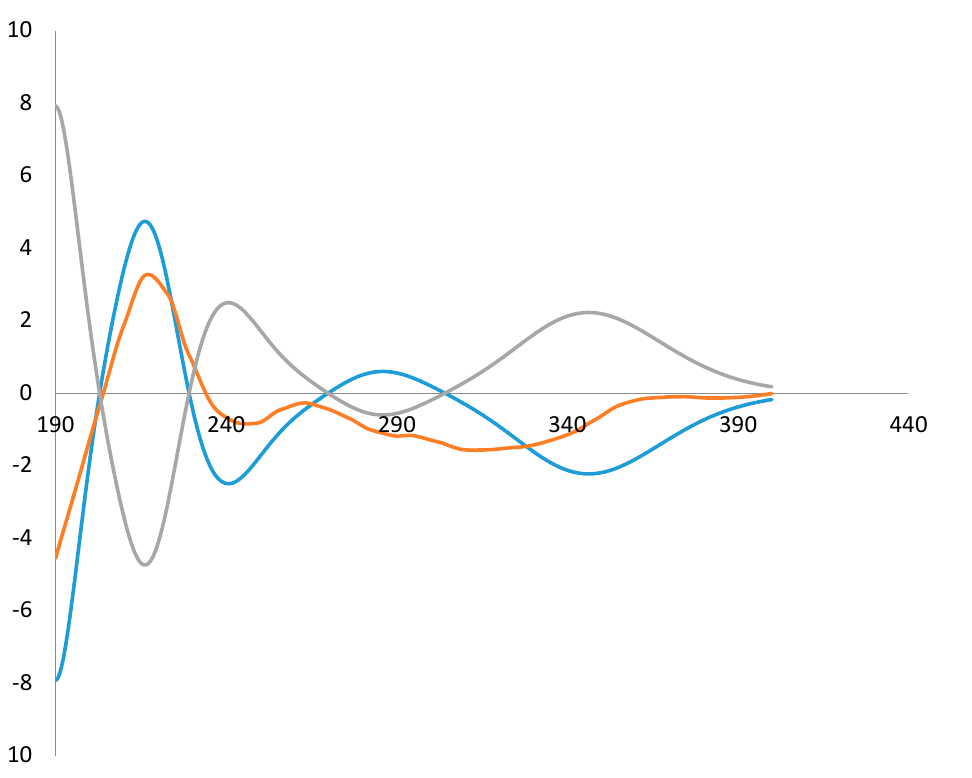
Figure 3. Comparison of the experimental ECD spectrum of 1 (red) with those calculated for the enantiomers 16-( R ) (blue) and 16-( S ) (green). (UV correction = 0 nm, bandwidth σ = 0.16 eV).